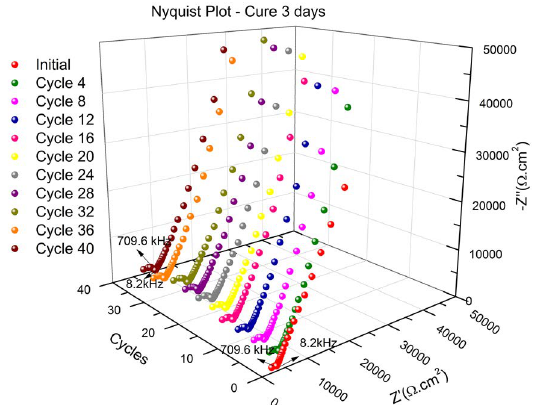
Figure 3. Nyquist Diagram - Cylindrical CC, cured for 3 days and submitted to 40 wetting and drying cycles.